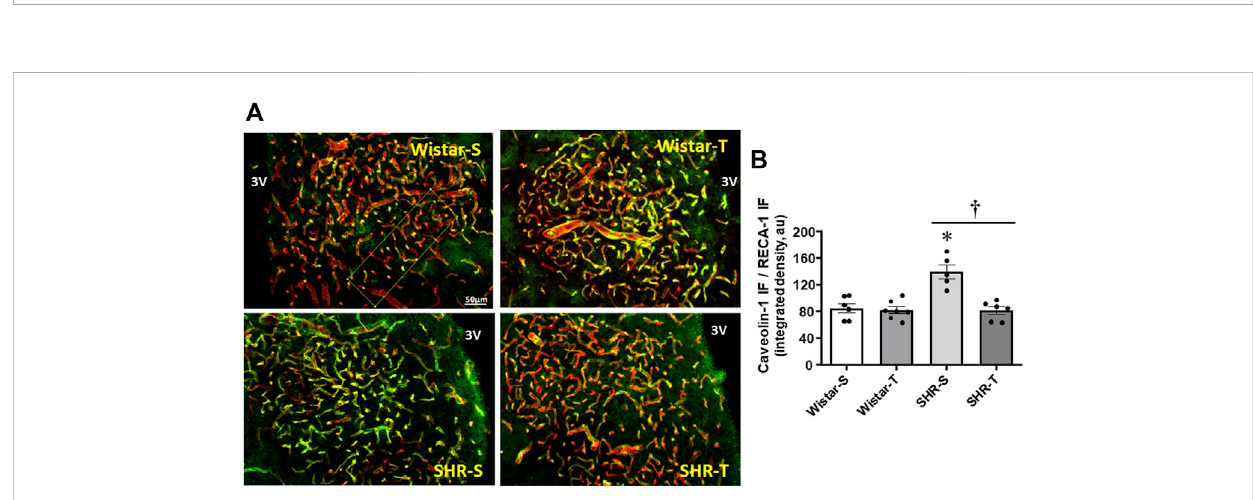
FIGURE 3 Effects of hypertension and exercise training on caveolin-1 content within the PVN. (A). Photomicrographs show caveolin-1 expression (green) withinPVNcapillaries(RECA-1,red)andthecolocalizationofboth(yellow)insedentary(S)andtrained(T)SHRandWistarrats.Scalebar=50 μ m,3V,third ventricle. (B). Comparison of PVN caveolin-1 immuno fl uorescence in the 4 experimental groups at the end of protocols. n = 5 – 7 slices/rat, 6 rats/group. Comparisons made by 2-way factorial ANOVA: group F (1,20) = 13.36, p = 0.002, condition (F1,20) = 19.03, p < 0.001, group x condition (F1,20) = 13.74, p = 0.001. Signi fi cances (p < 0.05) are * vs. respective Wistar group; † vs. respective S